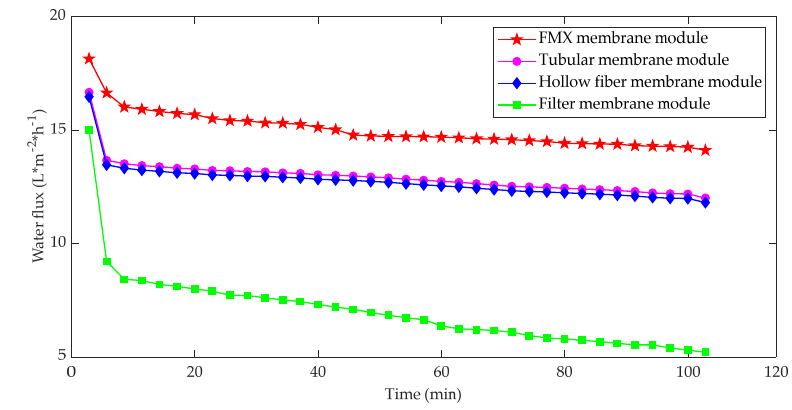
Figure 4. Variation of permeate flux of four membrane modules.